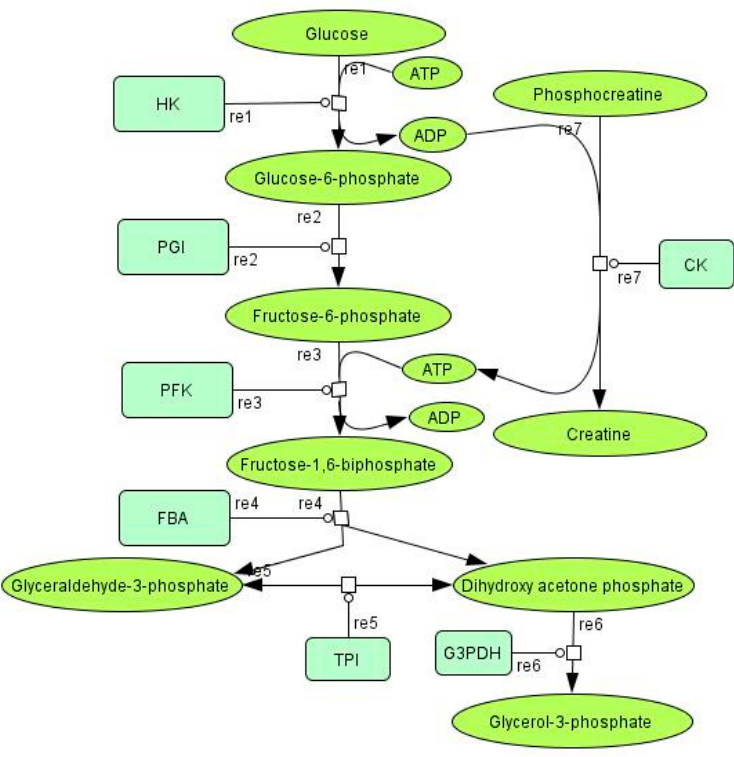
Figure 1. CellDesigner diagram for the upper part of glycolysis, which replicates the experimental conditions described by Fievet et al. [41]. HK: hexokinase, PGI: glucose 6- phosphate isomerase, PFK: phosphofructokinase, FBA: aldolase, TPI: triose-phosphate Isomerase, G3PDH: glycerol-3-phosphate dehydrogenase, CK: creatine kinase, re: reaction.